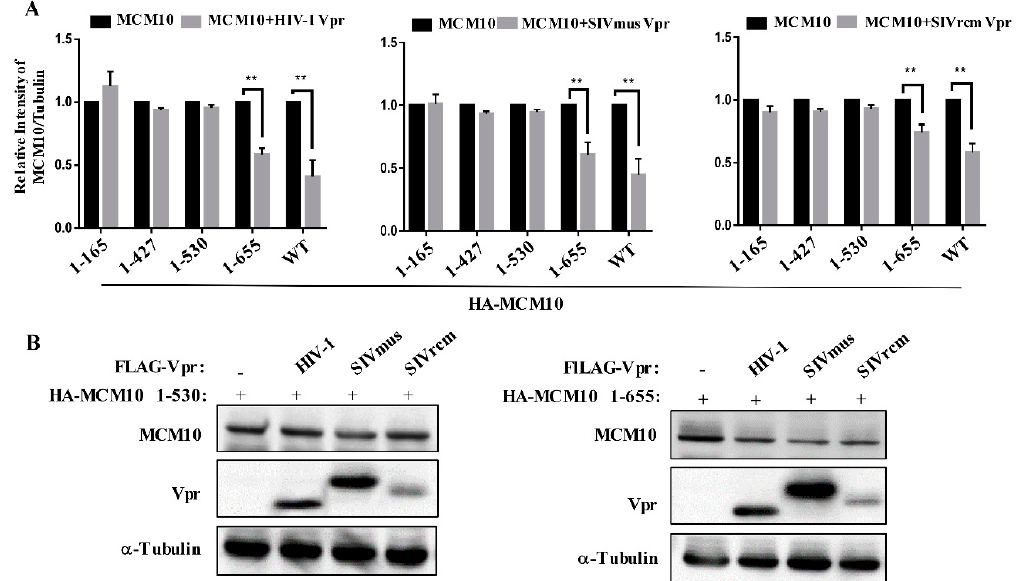
Figure 6. MCM 2-7 interaction region is susceptible to degradation by HIV-1, SIVmus, and SIVrcm Vprs. ( A ) HEK293T cells were transiently transfected with either pcDNA3.1/HA-MCM10 WT, HA-1-165, HA-1-427, HA-1-530, or HA-1-655 together with either pcDNA3.1/3 x FLAG-HIV-1, SIVmus, or SIVrcm Vprs. The cells were then harvested at 48 h after transfection and lysates with equal protein amounts were subjected to western blotting. Band densities of HA-MCM10 and α -Tubulin were quantified by densitometry analysis using ImageJ software. The relative intensities were calculated as the ratio of density of MCM10 to density of α -Tubulin (lower panel). Each column and error bar represents the mean ± SD for three independent experiments (right panel). The asterisks indicate a statistically significant difference (** p < 0.01). ( B ) HEK293T cells were transiently transfected with either pcDNA3.1/HA MCM10-1-530, or 1-655 together with either pcDNA3.1/3 × FLAG-HIV-1, SIVmus, or SIVrcm Vprs to analyze western blotting. The positions of 3 × FLAG-Vpr, HA-MCM10 and α -Tubulin are indicated.